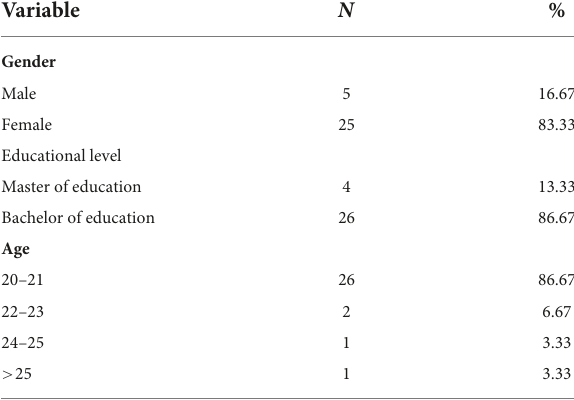
TABLE 1 Demographic characteristics of